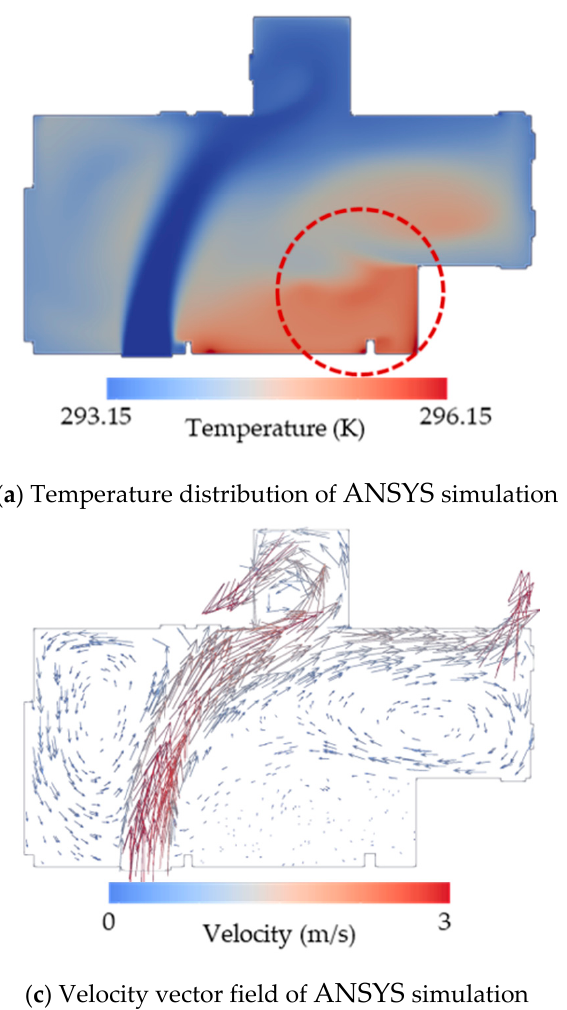
Figure 8. Difference in temperature distribution and vector filed at C-type according to optimization.